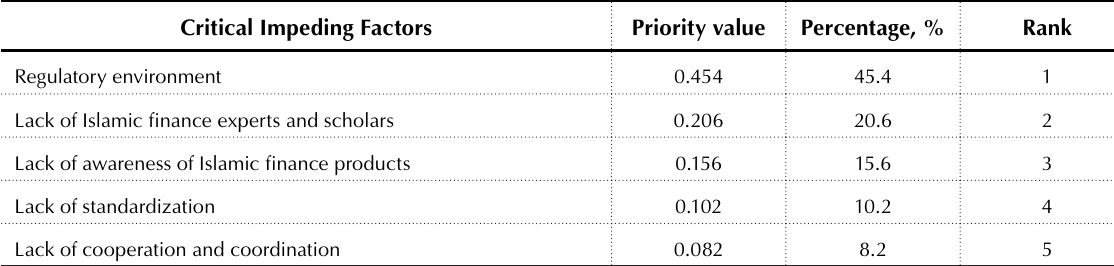
Table 3. Ranking of Critical Impeding Factors